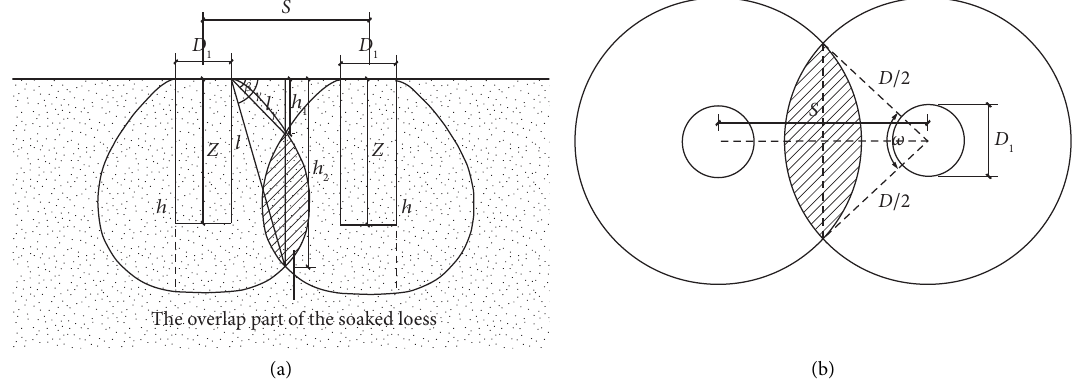
Figure 3: (a) Vertical profile of the soaked soil volume when passed through two water injection holes to soak. (b) Horizontal section at the maximum percolation radius of the soaked soil volume.